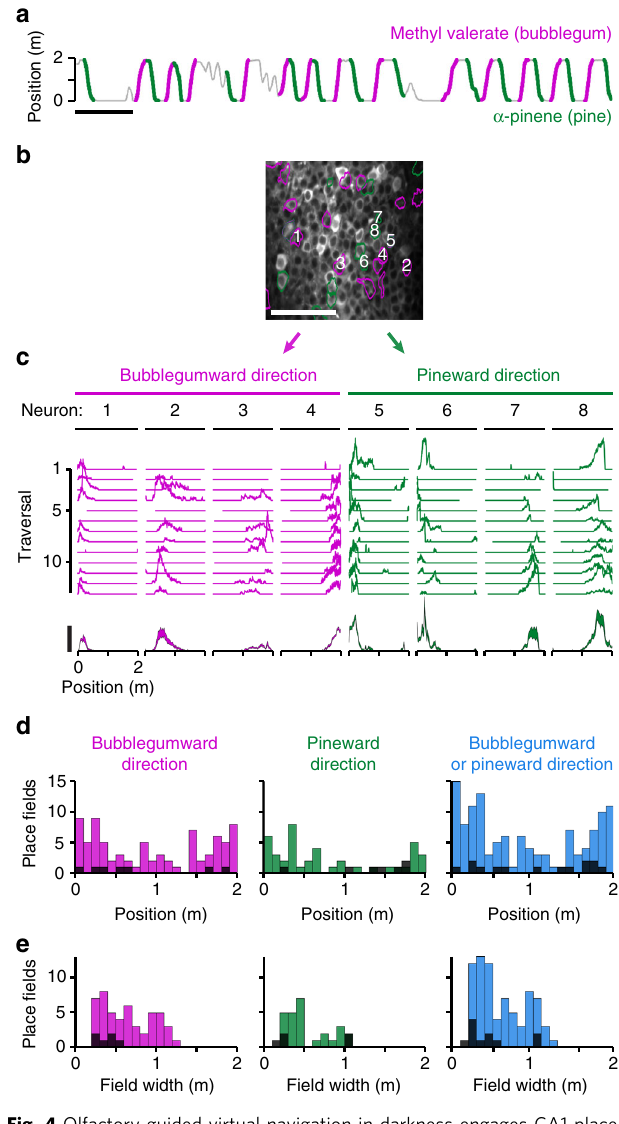
Fig. 4 Olfactory-guided virtual navigation in darkness engages CA1 place cells. a Position of a mouse behaving in VR. Traversals in the bubblegumward and pineward direction are colored pink and green, respectively. Scale bar = 1 min. b Averaged fi eld of view of CA1 stratum pyramidale during the behavioral session shown in a as measured by 2- photon calcium imaging. Each signi fi cant place cell is outlined with the color indicating the direction in which its place fi eld occurs. Neurons with place fi elds in both directions are outlined in both colors. Scale bar = 100 µ m. c Traversal-by-traversal (top, arbitrary units) and mean change in fl uorescence (bottom, Δ F / F , mean ± s.e.m.) for each neuron numbered in b during traversals in its preferred direction as indicated in a . Scale bar = 100% Δ F / F . d Histograms of all mean place fi eld peak locations during traversals in the bubblegumward direction (left), the pineward direction (middle), or either direction (not both directions) (right), pooled from seven mice, one session per mouse. Colored bars represent the dark odor condition and black bars represent the dark + fl at condition for the same fi elds of view during the same behavioral sessions. e Histograms of all place fi eld widths for the same data as described in